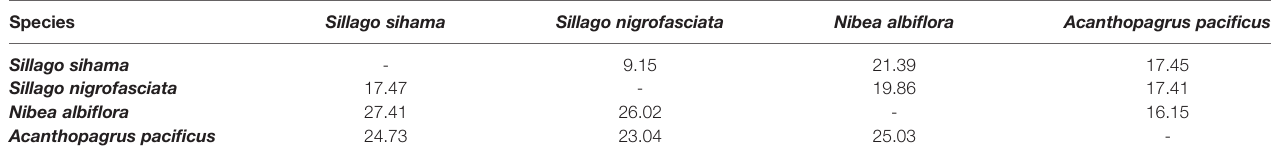
TABLE 3 | Interspeci fi c divergence based on K2P distance (%) using COI sequences (lower matrix) and 16S rRNA sequences (upper matrix) of eggs and fi sh specimens from four species. Species Sillago sihama Sillago nigrofasciata